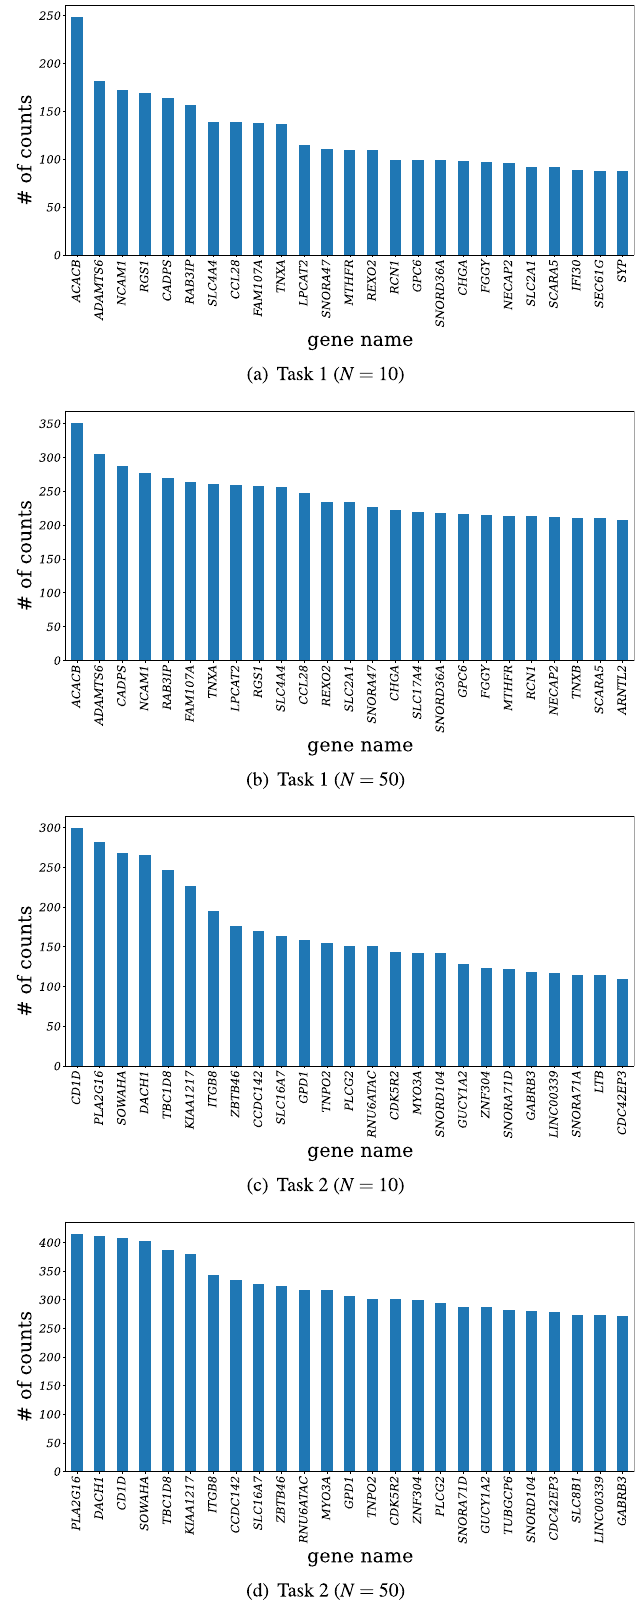
Figure 3. The number of counts of the top 25 genes ranked in the top 10 and 50 positions during 1000